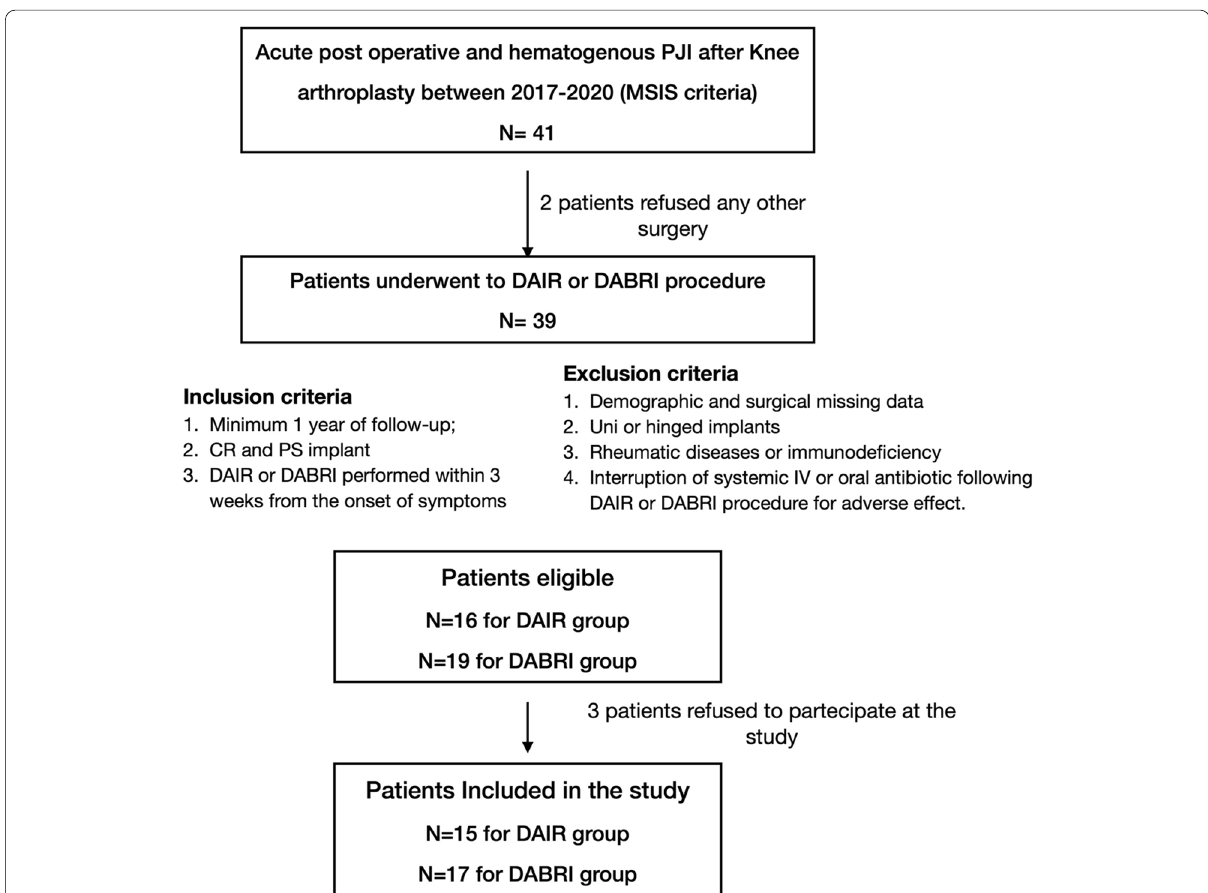
Fig. 1 Flowchart of the study. PJI: Prosthetic Joint Infections; MSIS: Musculoskeletal Infection Society; DAIR: Debridement, antibiotics and implant retention; DABRI: Debridement, antibiotics bead and retention implant; CR: cruciate-retaining; PS: posterior-stabilized; Uni: unicompartmental; IV: